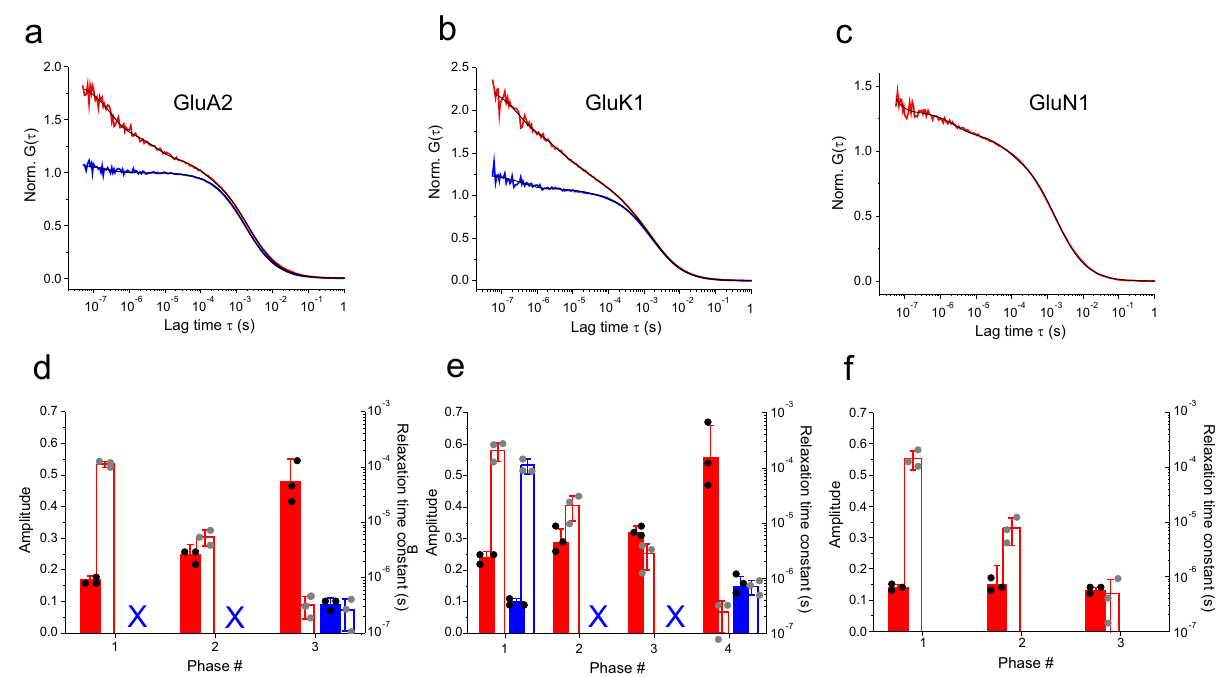
Fig. 2 Clamshell dynamics of AMPA, kainate and NMDA iGluR LBDs in the apo state measured using FCS. a – c ACFs (G( τ )), normalized to the average number of molecules in the detection focus, recorded from GluA2 ( a ), GluK1 ( b ), and GluN1 ( c ) LBDs. ACFs of GluA2-LBD-G446C ( a ) and GluK1-LBD- K503C ( b ) are shown in blue. ACFs of GluA2-LBD-G446C-T685W ( a ) and GluK1-LBD-K503C-K734W ( b ) are shown in red. The ACF of GluN1-A480C is shown in red ( c ). Black lines are fi ts to the data using a model for molecular diffusion containing a sum of one to four single-exponential relaxations (indicated in ( d – f )). d – f Amplitudes (closed bars) and corresponding time constants (open bars) obtained from fi ts to detected exponential phases in ACFs of the GluA2 ( d ), GluK1 ( e ) and GluN1 ( f ) LBD. Data sets and color code correspond to the ACFs shown in panels ( a – c ). Crosses (X) denote missing (not detected) kinetics. Error bars are s.d. of three measurements ( n =